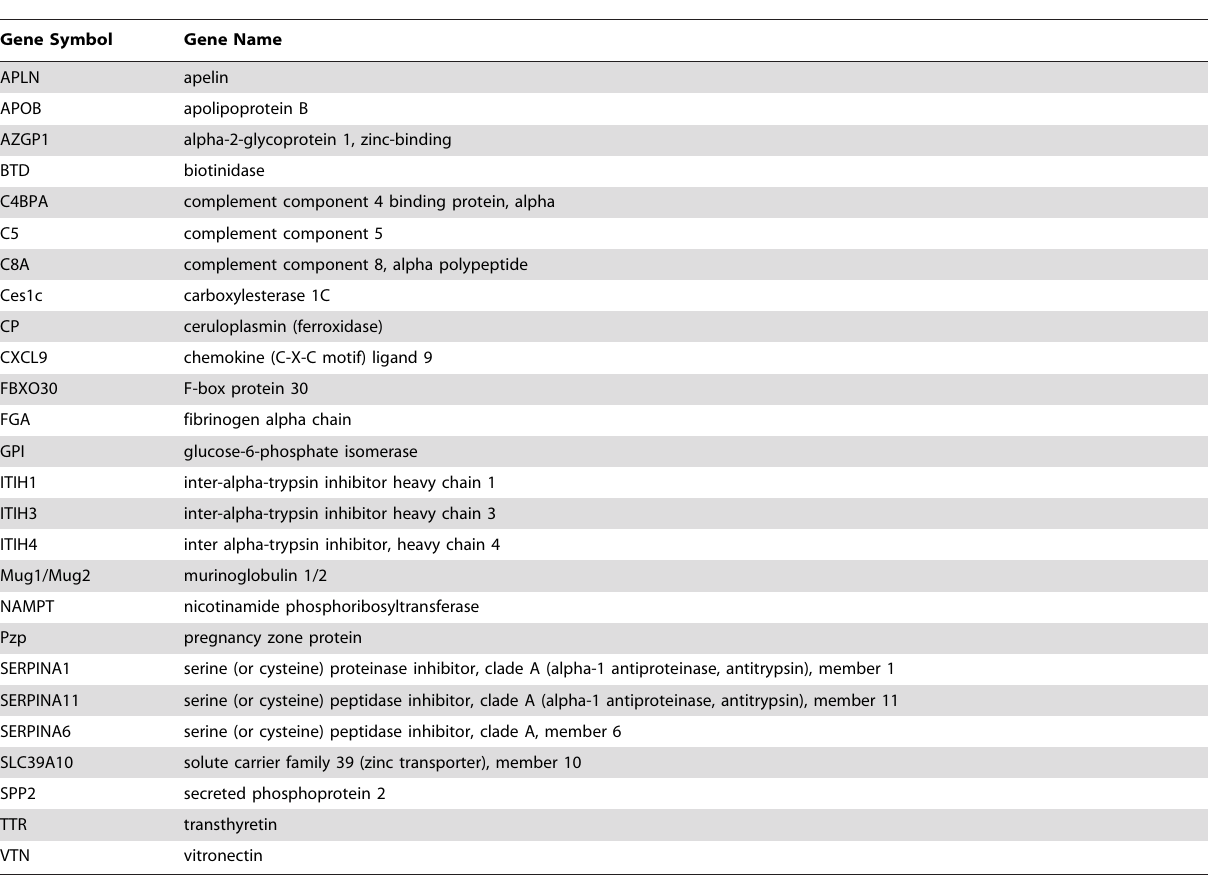
Table 3. Modulated Extracellular Transcripts and